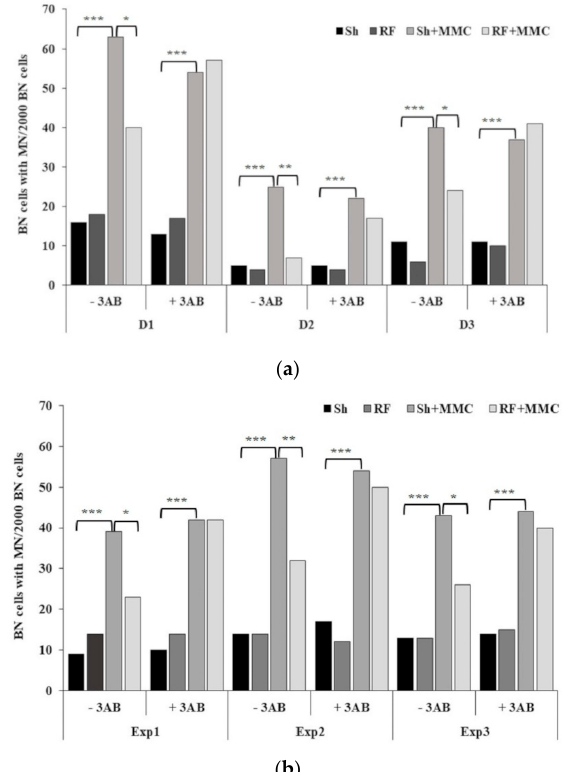
Figure 2. Micronuclei (MN) frequency in 2000 binucleate (BN) cells on ( a ) human peripheral blood lymphocytes from three donors (D1–D3), and ( b ) in three independent experiments on V79 cells (Exp1–3). For each cell type, results of Sh, RF, Sh + MMC, and RF + MMC treatments are reported, in the absence and in the presence of 3AB. χ 2 test: * p < 0.05; ** p < 0.01; *** p <<